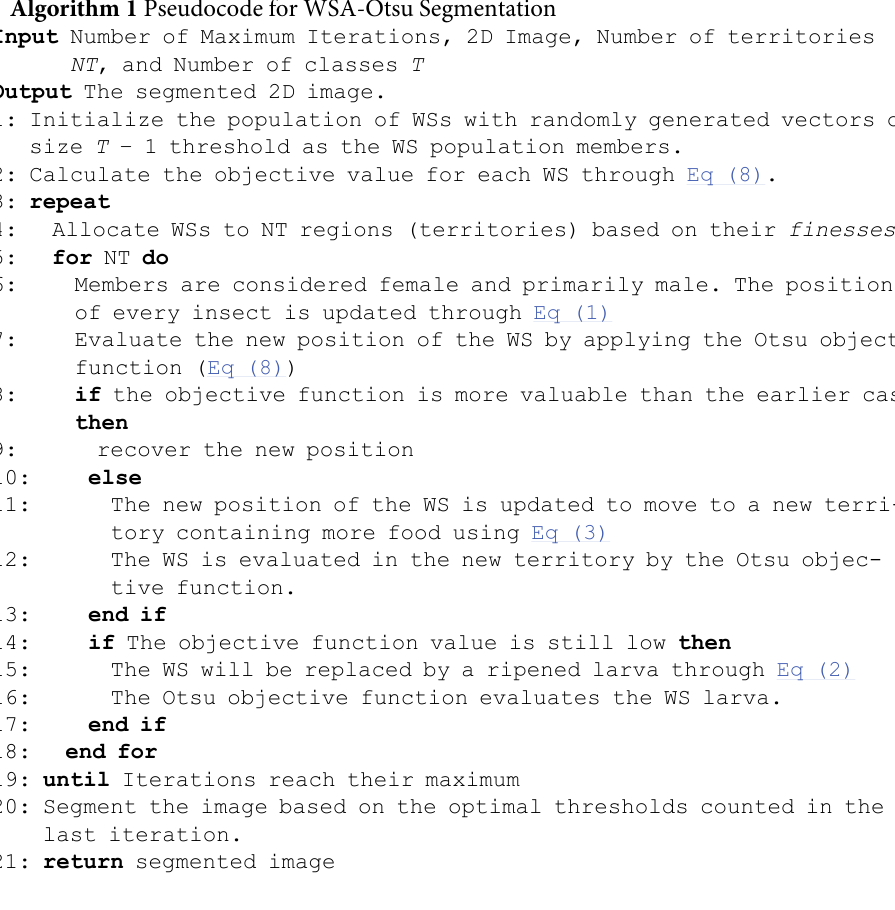
Algorithm 1 Pseudocode for WSA-Otsu